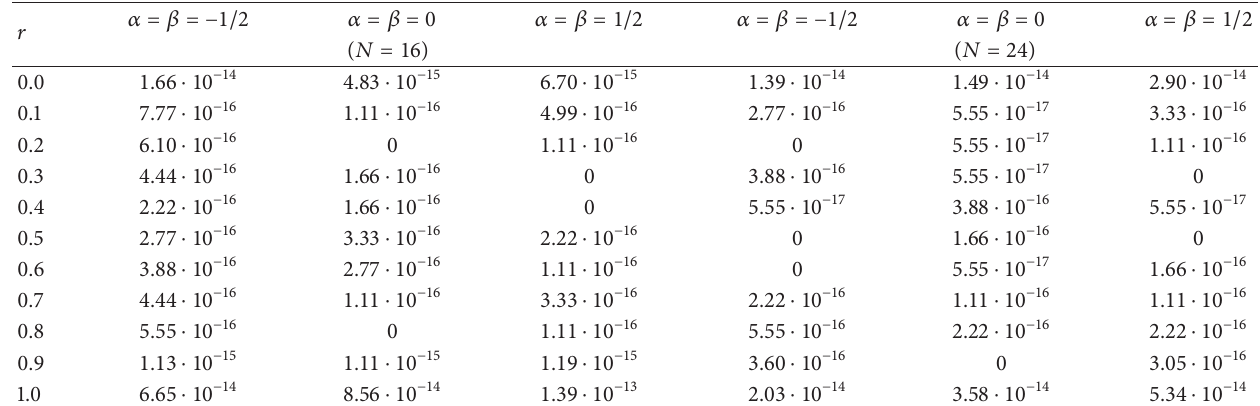
Table 6: Absolute residual error functions for 𝑛 = 2, 𝜆 = −1/3